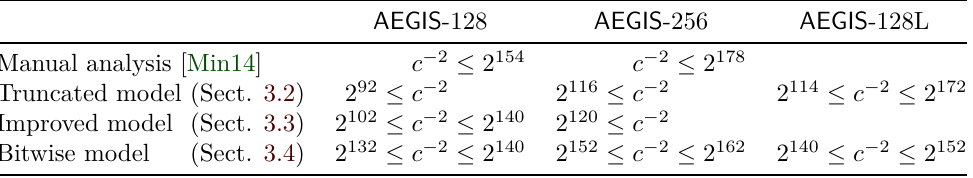
Table 1: Bounds for the inverse squared correlation contribution c − 2 of the best suitable linear characteristics of AEGIS . Lower bounds are derived using MILP models, upper bounds are based on best found characteristics (see Subsection 4.3 on their accuracy). AEGIS